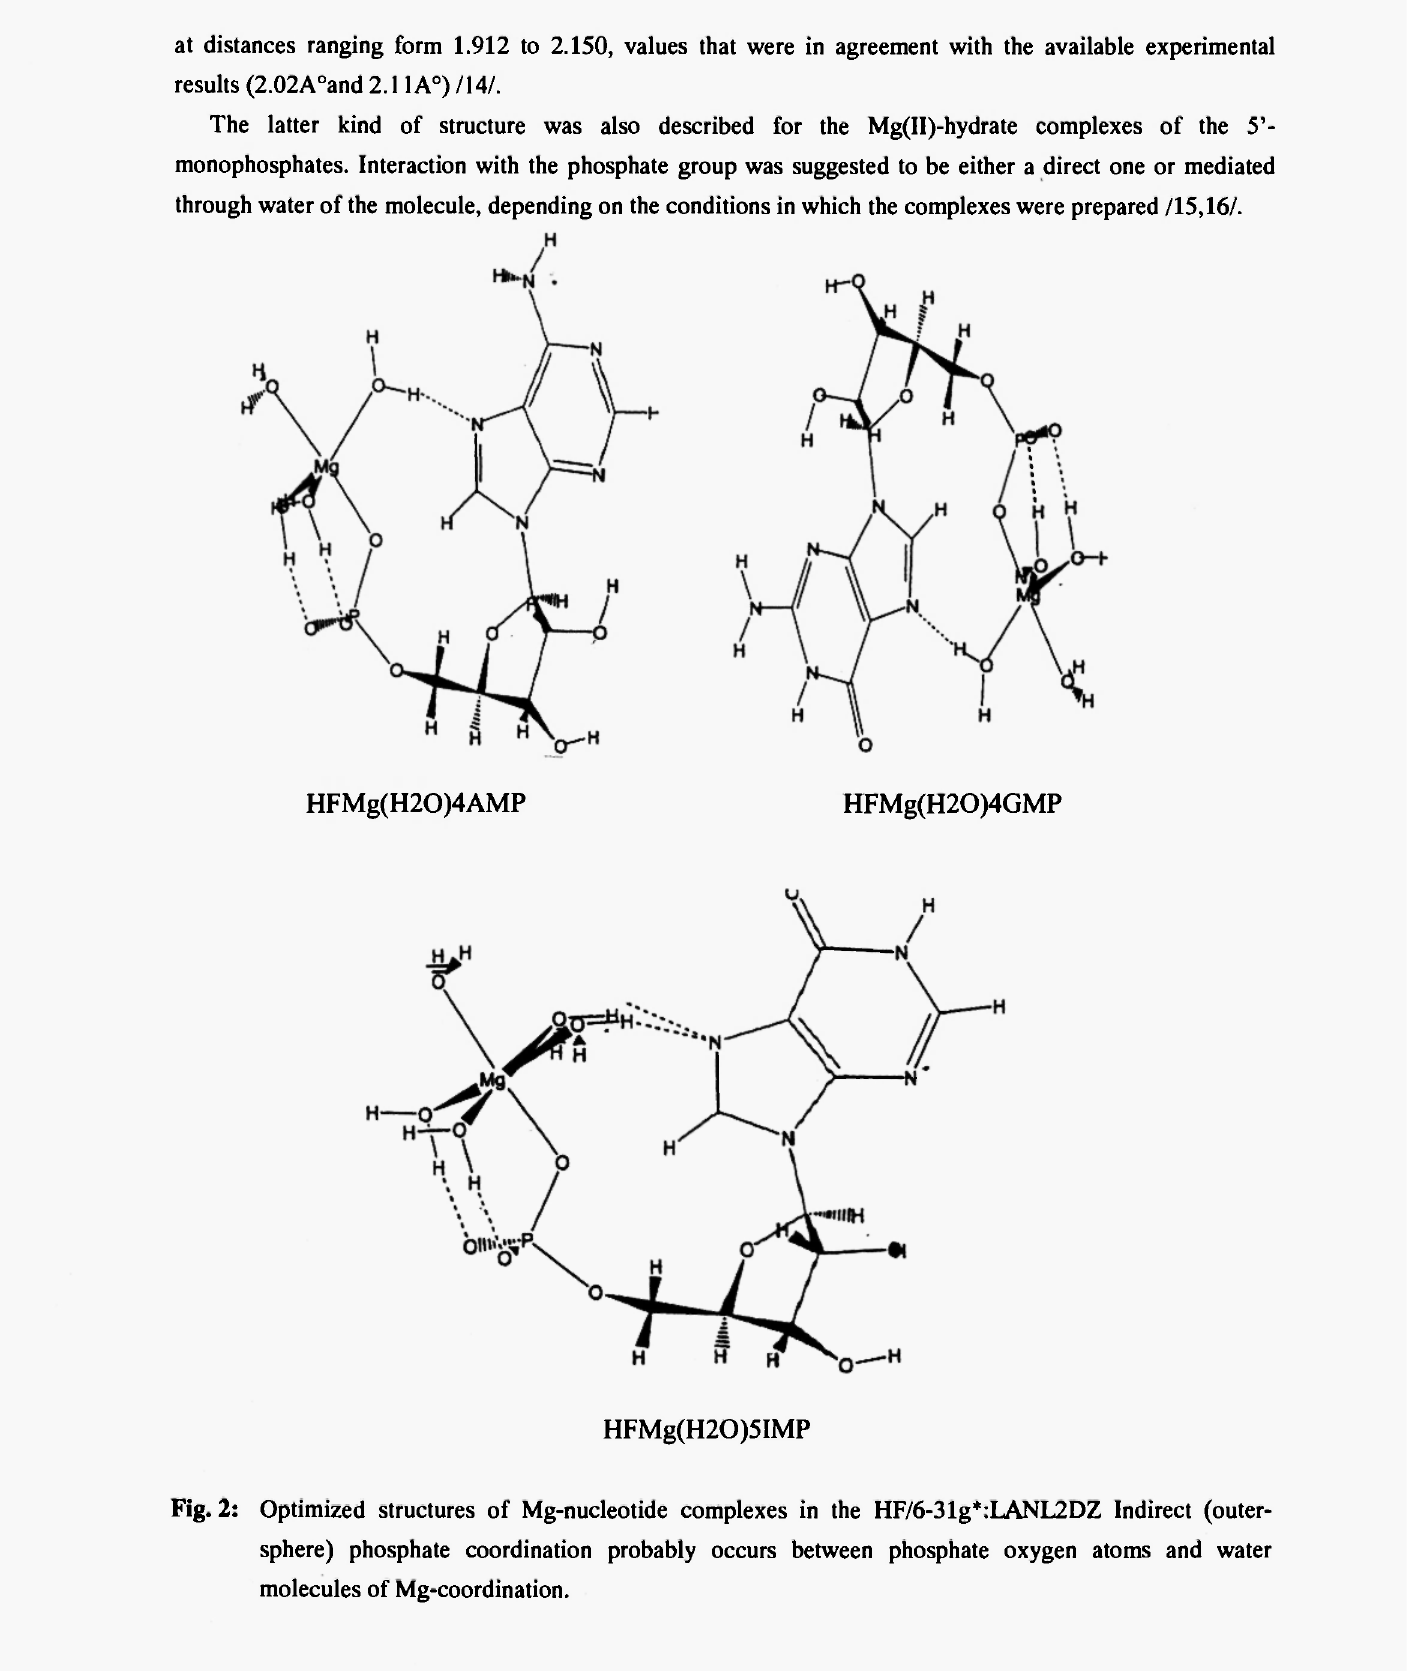
Fig. 2: Optimized structures of Mg-nucleotide complexes in the HF/6-31g*:LANL2DZ Indirect (outer- sphere) phosphate coordination probably occurs between phosphate oxygen atoms and water molecules of